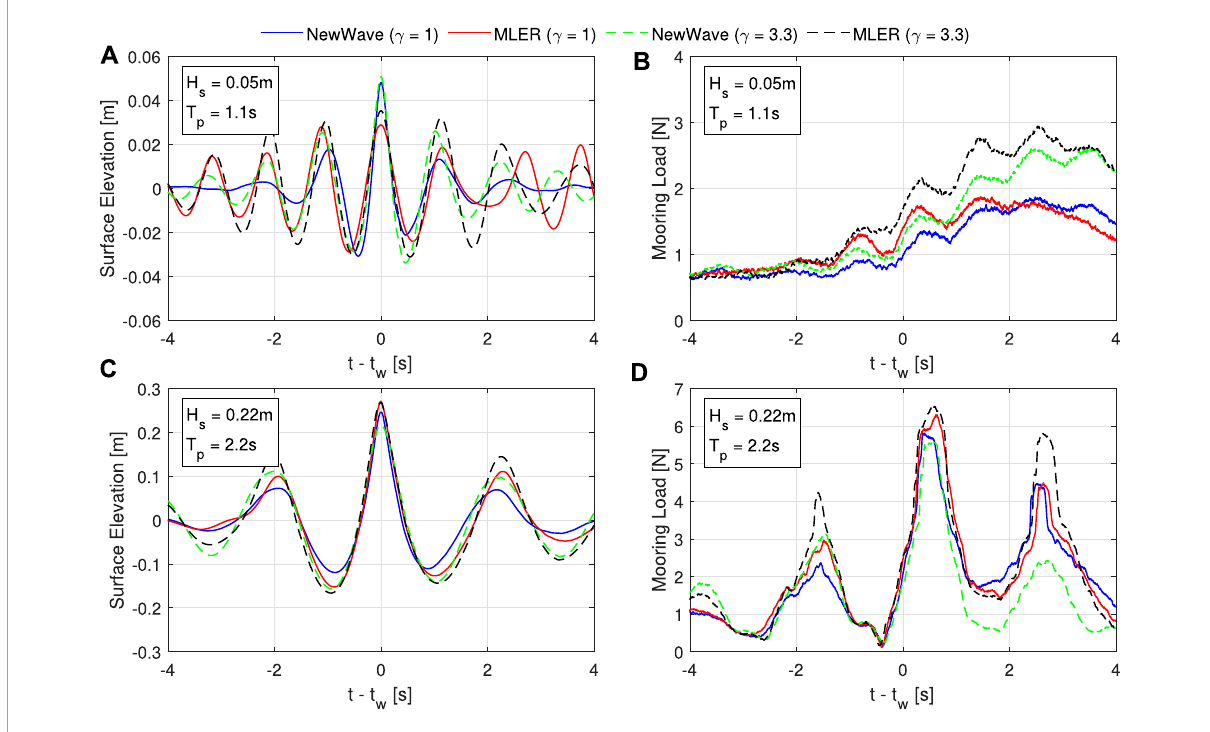
FIGURE 7 Surface elevation (A,C) and mooring load (B,D) time series for each single SDWs: NewWave, γ = 1 (blue solid); MLER, γ = 1 (red solid); NewWave, γ = 3 . 3 (green dashed); MLER, γ = 3 . 3 (black dashed). The top row (A,B) presents the Resonance sea state ( T p = 1 . 1s, H s = 0 . 05 m) and the bottom row (C,D) the 50-year sea state ( T p = 2 . 2s, H s = 0 . 22 m). Time is relative to the peak wave elevation, t w .